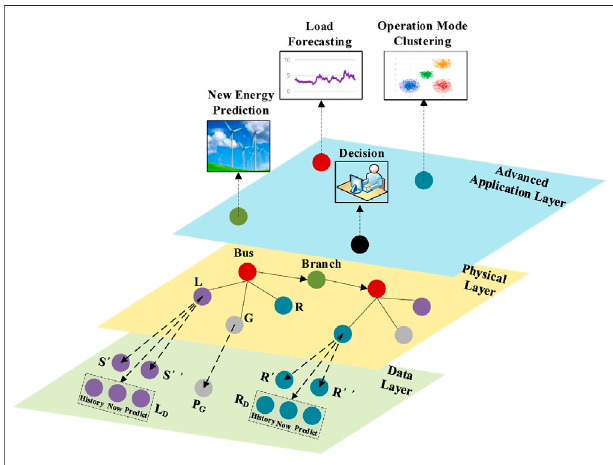
FIGURE 3 | Multi-level knowledge graph for power system dispatching